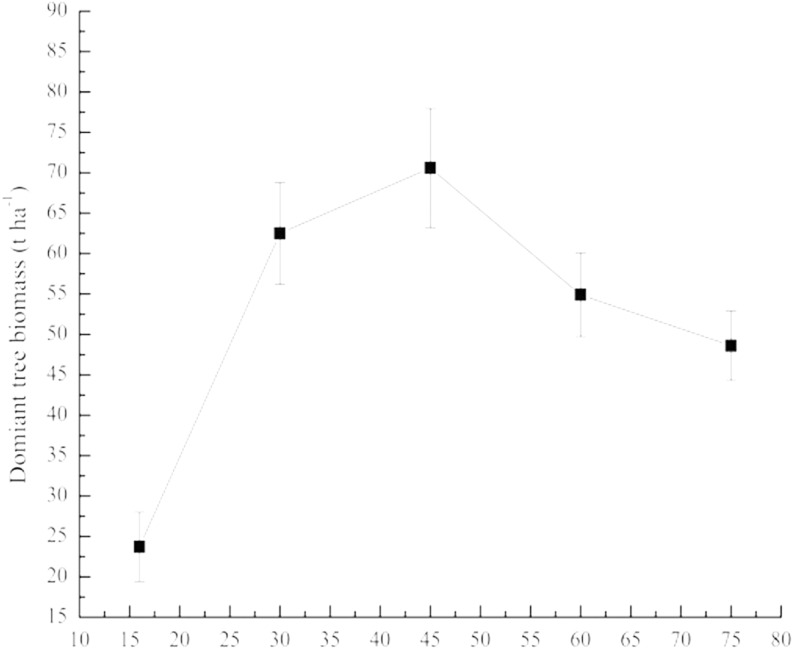
Biomass of Pinus tabulaeformis in protected stands.Error bars are from one-way analysis of variance (ANOVA). Confidence interval of 95% for biomass of dominant tress is [22.87, 74.25].